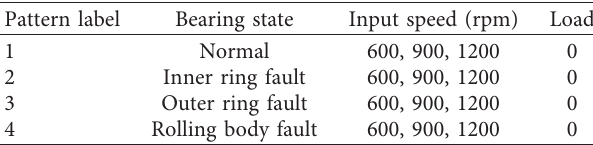
Table 1: The data of rolling bearings used in the test. Pattern